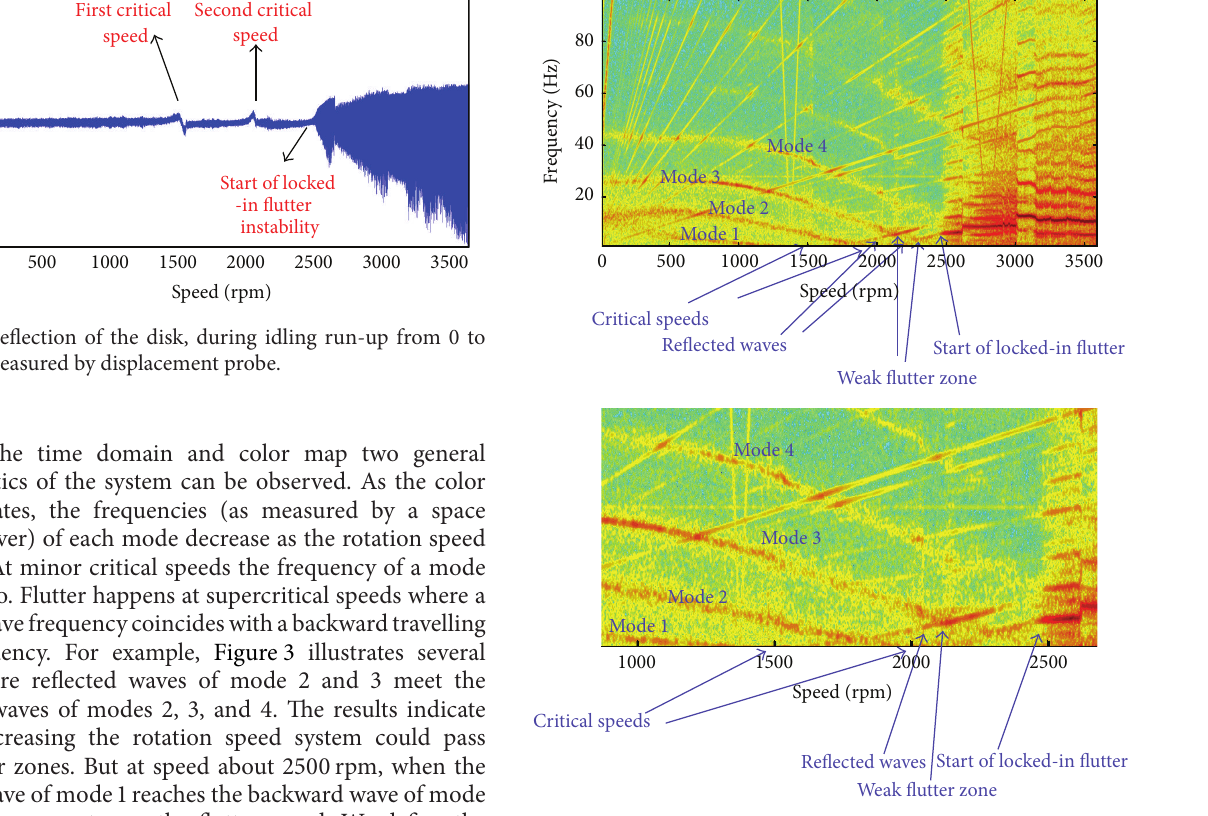
Figure 3: Variation of excited frequencies of the disk as a function of rotation